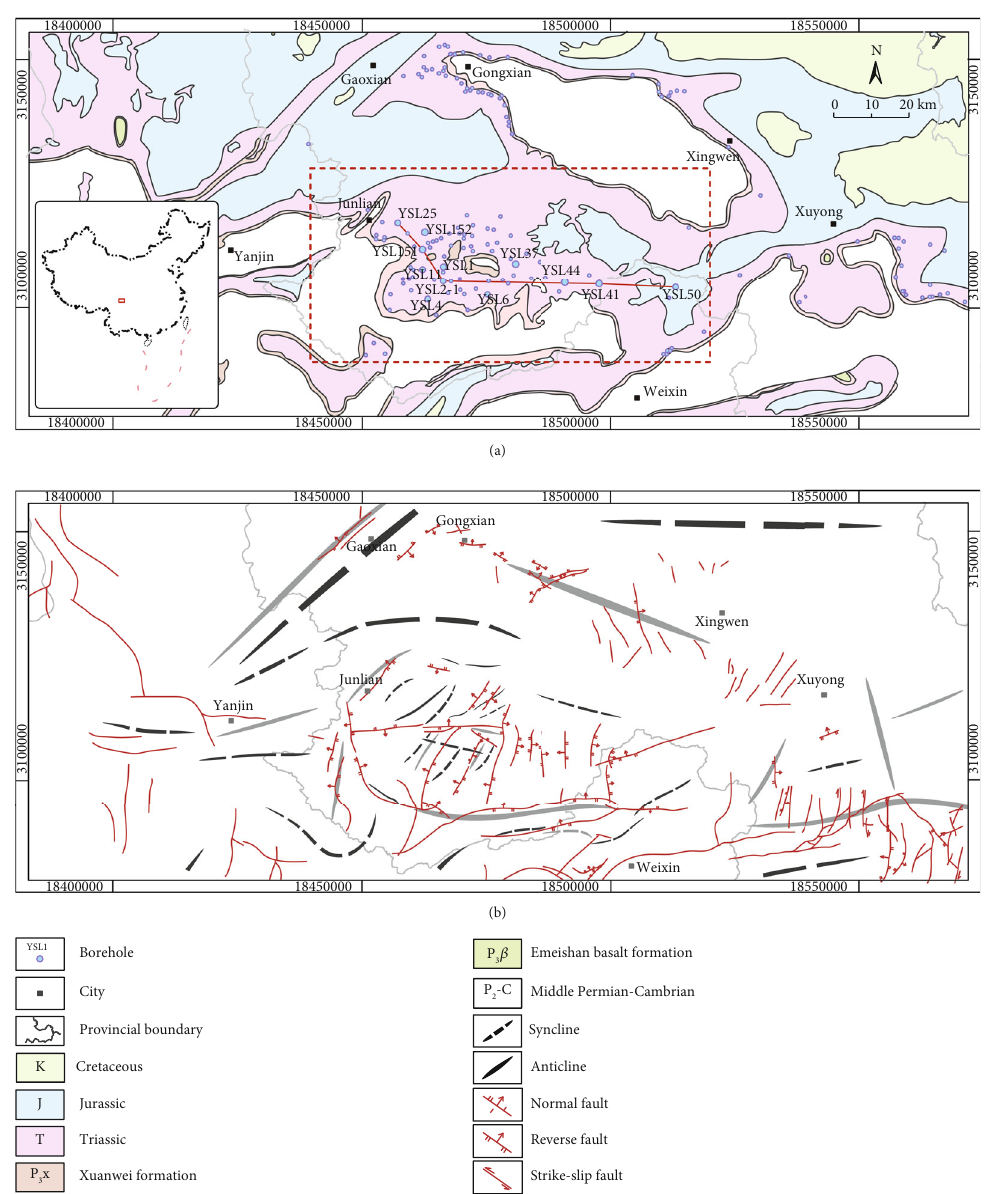
Figure 1: Stratigraphic distribution and tectonic outline of the Junlian coal fi